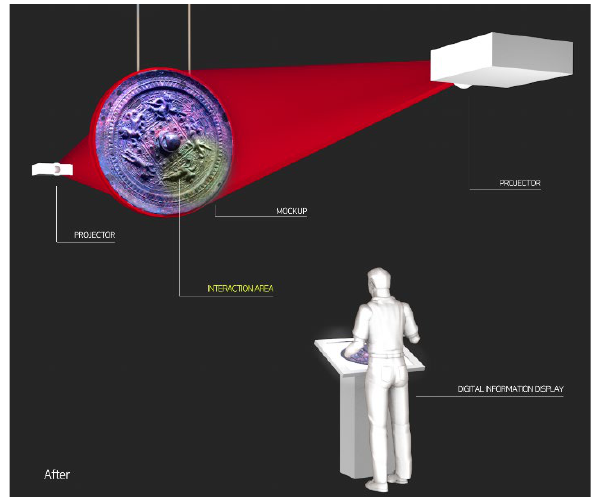
Figure 3. Schematic image of projection mapping for